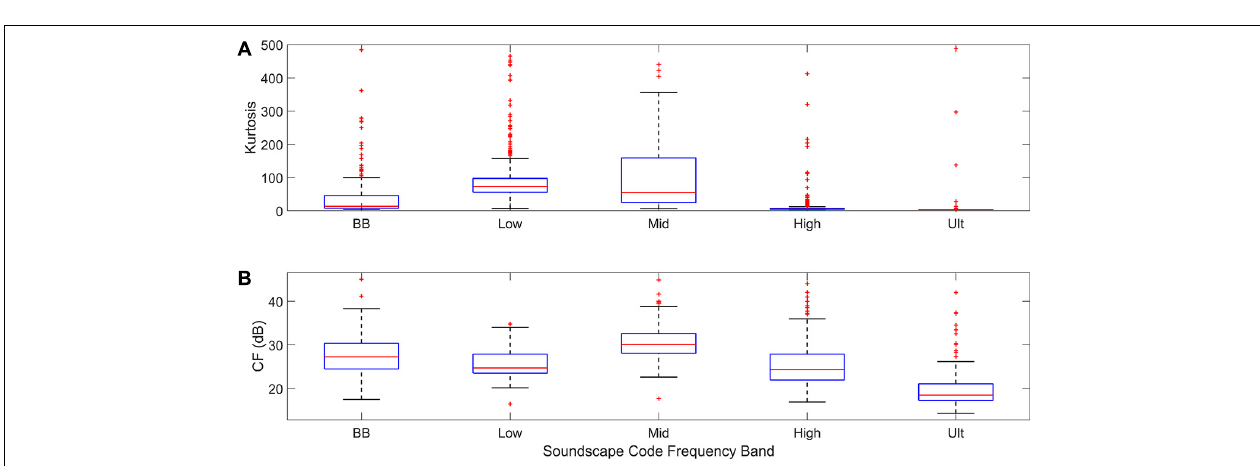
FIGURE 3 | A priori metric response expectations for each data set. Expectations formed criteria to compare metrics and inform the metric selection. Green-Yellow-Red coloration represents relative expected metric response level where green indicates a low property level, yellow indicates a mid-level, and red indicates high-level responses. Low-level responses for the uniformity category indicate a uniform acoustic environment, and high-level responses indicate a lack of uniformity. Corresponding soundscape code frequency band is indicated by abbreviations for Broadband (BB), Low (L), Mid (M), High (H), Ultra-High (UH).